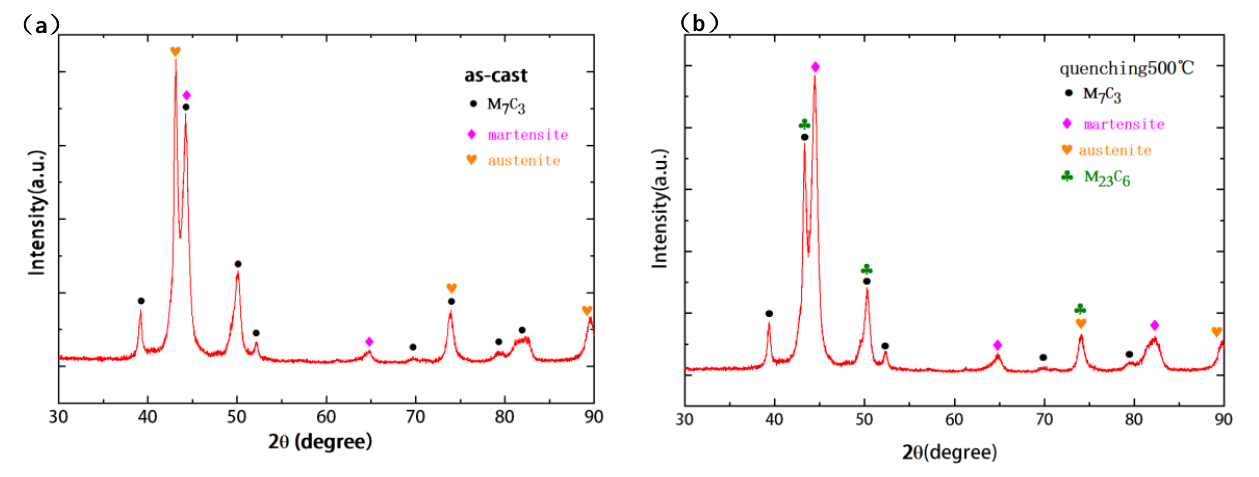
Figure 10. X-ray diffraction determines the phase composition of microstructure: ( a ) As-cast; ( b ) Quenching temperature 500 ◦